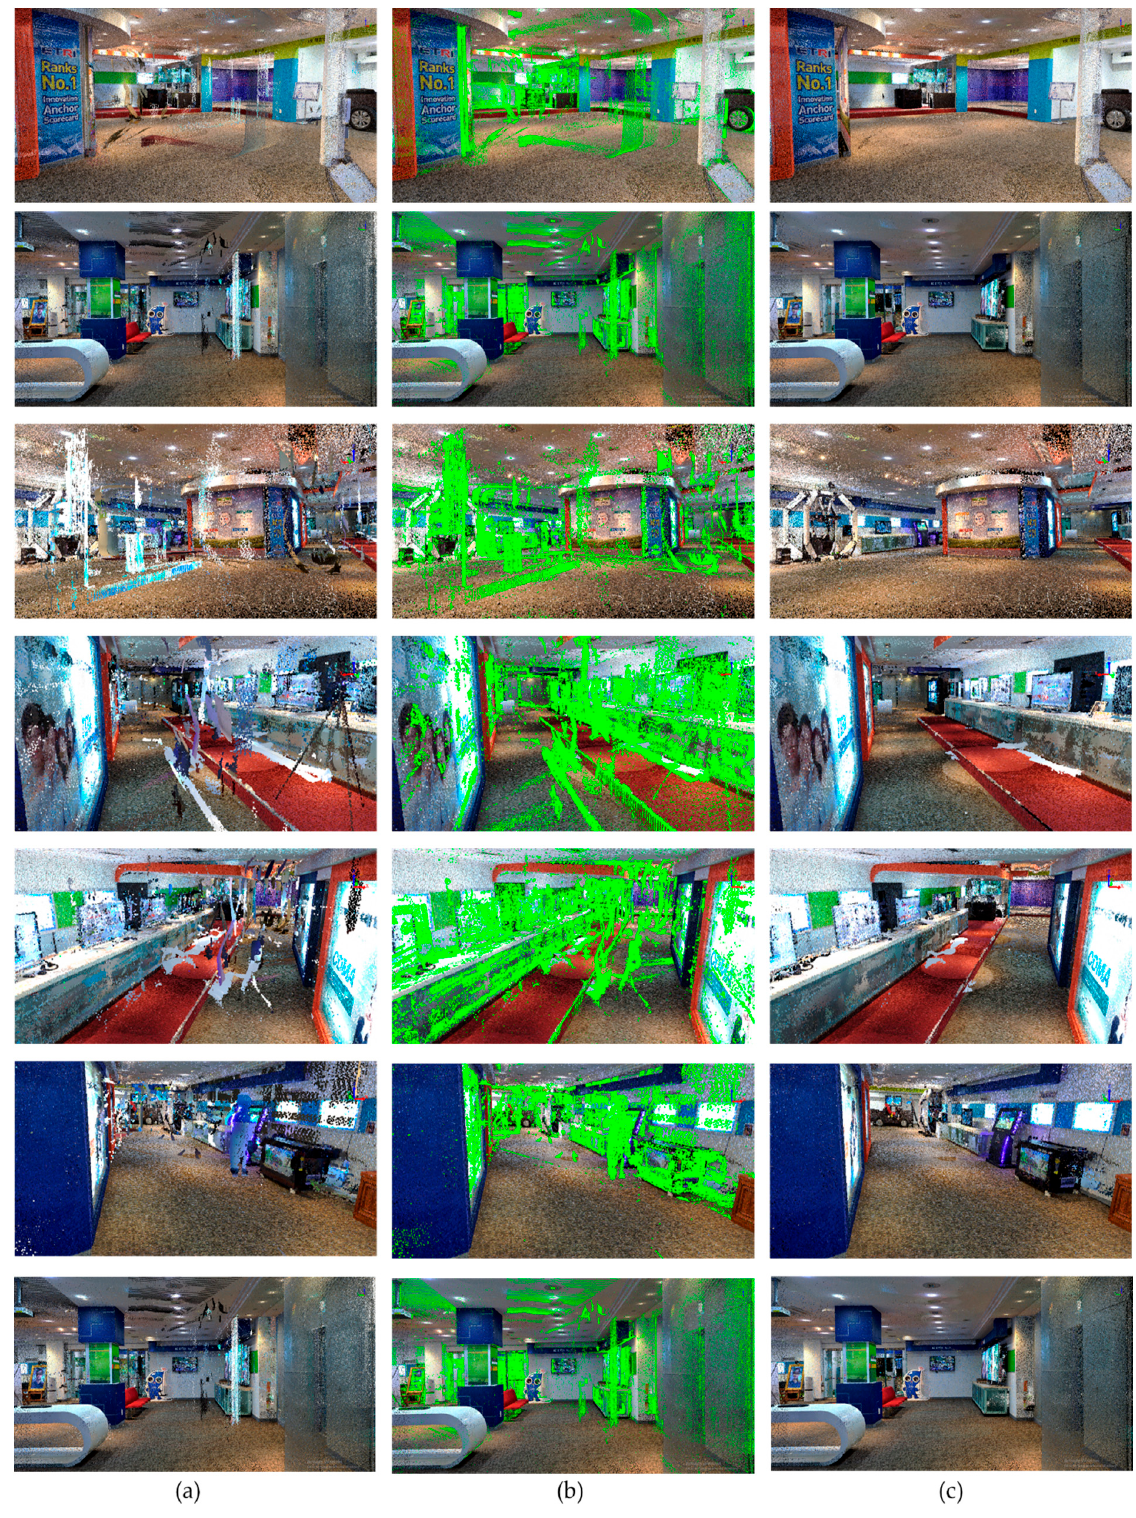
Figure 16. Results of the proposed method. ( a ) is the original point cloud image, ( b ) the green part of the figure is the reflected noise region detected by our method, and ( c ) is the result obtained after denoising using our method. Figure 17 shows a comparison of the proposed results with the FARO SCENE de- noising results. Here, (a) shows the original point cloud view, (b) shows the result after